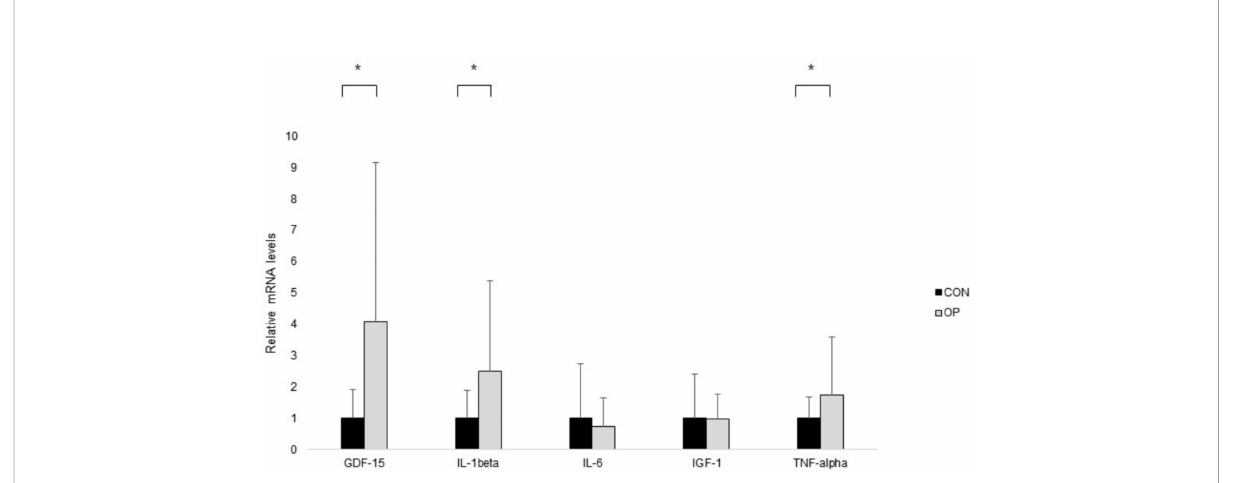
FIGURE 2 The results of real-time PCR. Normalized fold expressions of mRNA are shown. The error bar represents the mean ± standard error. To compare gene expression levels between groups, independent t-test was applied (* P < 0.05).